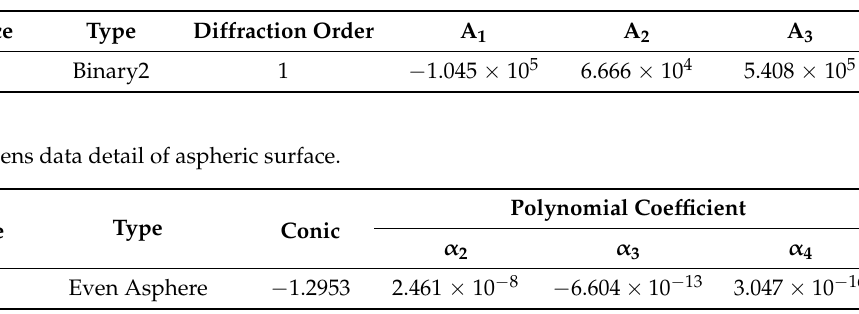
Table 3. Lens data detail of single-layer DOE.